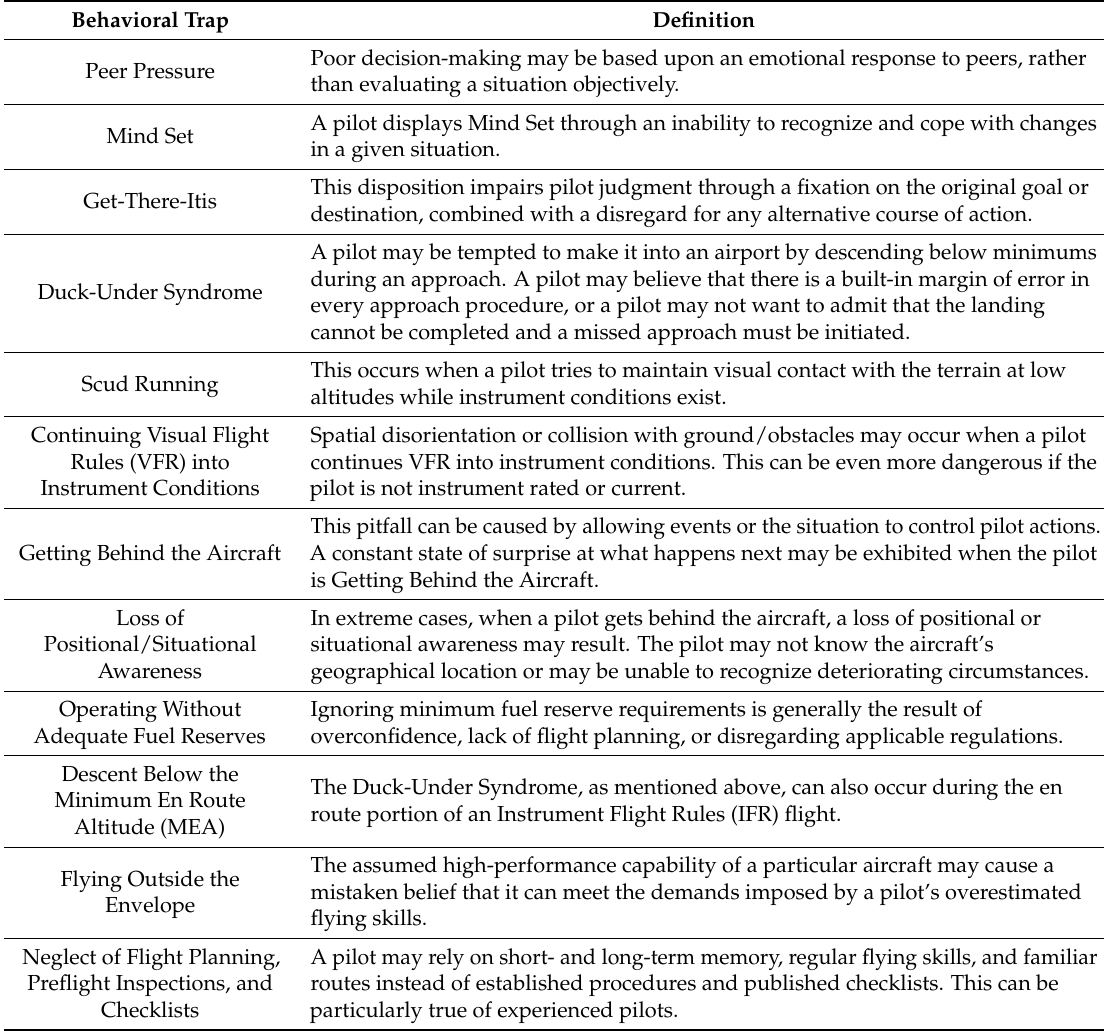
Table 2. Overview of behavioral traps as defined by the FAA